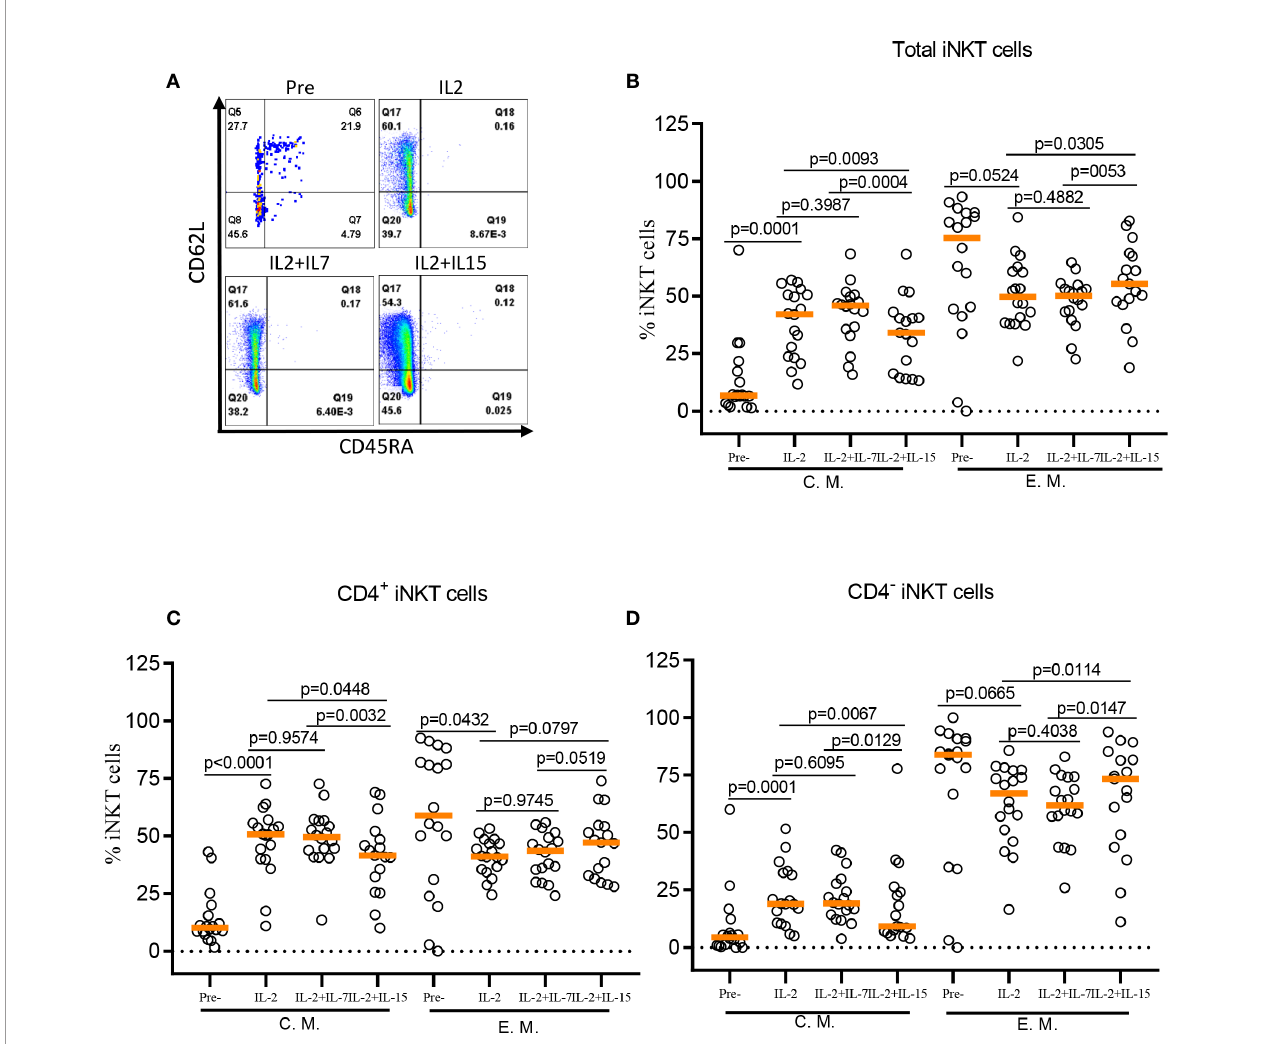
FIGURE 4 | IL-7 but not IL-15 supports the expansion of CD62L + central memory iNKT cells. (A) Representative fl ow cytometry analysis of CD62L and CD45RA expression on total iNKT cells before and after antigen speci fi c expansion with IL-2, IL-2+IL-7, and IL-2+IL-15. (B – D) The percent of central memory (CM, CD45RA - CD62L + ) and effector memory (EM, CD45RA + CD62L - ) phenotype of total, CD4 + , and CD4 - iNKT cells in pre- and post-expansion. Horizontal orange lines show median values; p values are shown above each group. Each symbol represents a value from a single